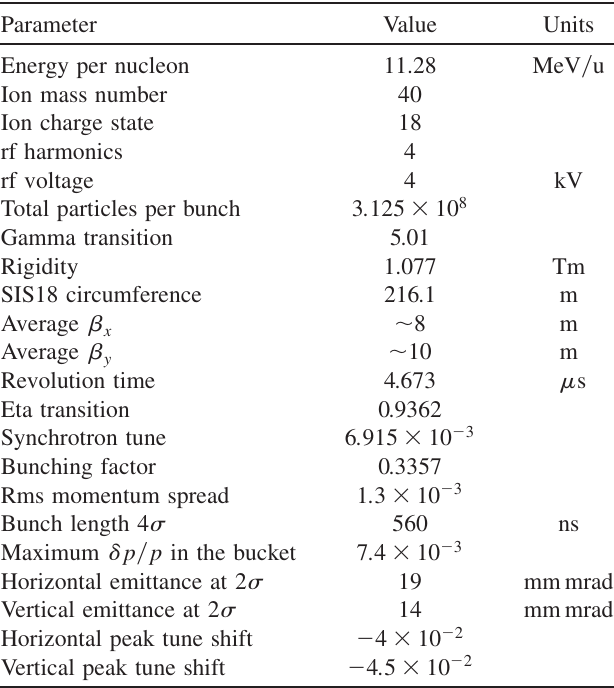
TABLE I. Typical parameters of SIS18 and of the ion beam used.